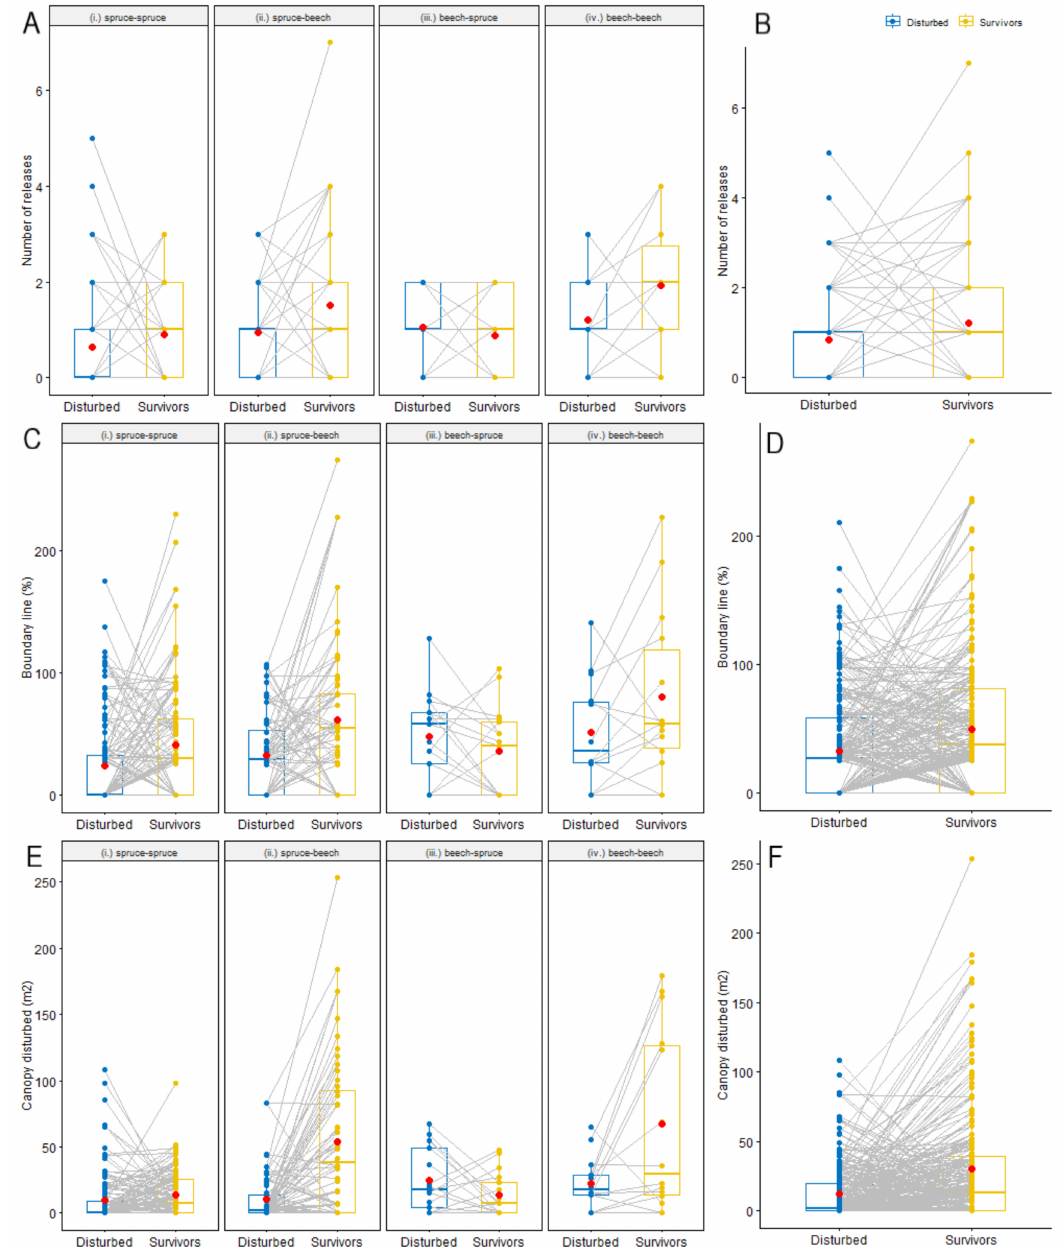
Figure 6. Paired boxplots of characteristics of disturbance frequency and intensity for both dendrochronological datasets for: ( A ) the number of releases sorted by species pairs; ( B ) the number of releases for all species; ( C ) the percent sum of boundary lines sorted by species pairs; ( D ) the percent sum of the boundary lines for all species; ( E ) the canopy area disturbed, sorted by species pairs; ( F ) the canopy area disturbed for all species. Blue and yellow boxes and points represent disturbed and survivor datasets, respectively. The hinges correspond to the 25th and 75th percentiles, with the thick solid line showing the median and red circles the mean values. The upper and lower whisker ends represent 1.5 ⁄ IQR of the hinge, where IQR is the inter-quartile range. Points beyond the whisker ends are regarded as outliers. Grey lines connect individual trees within the